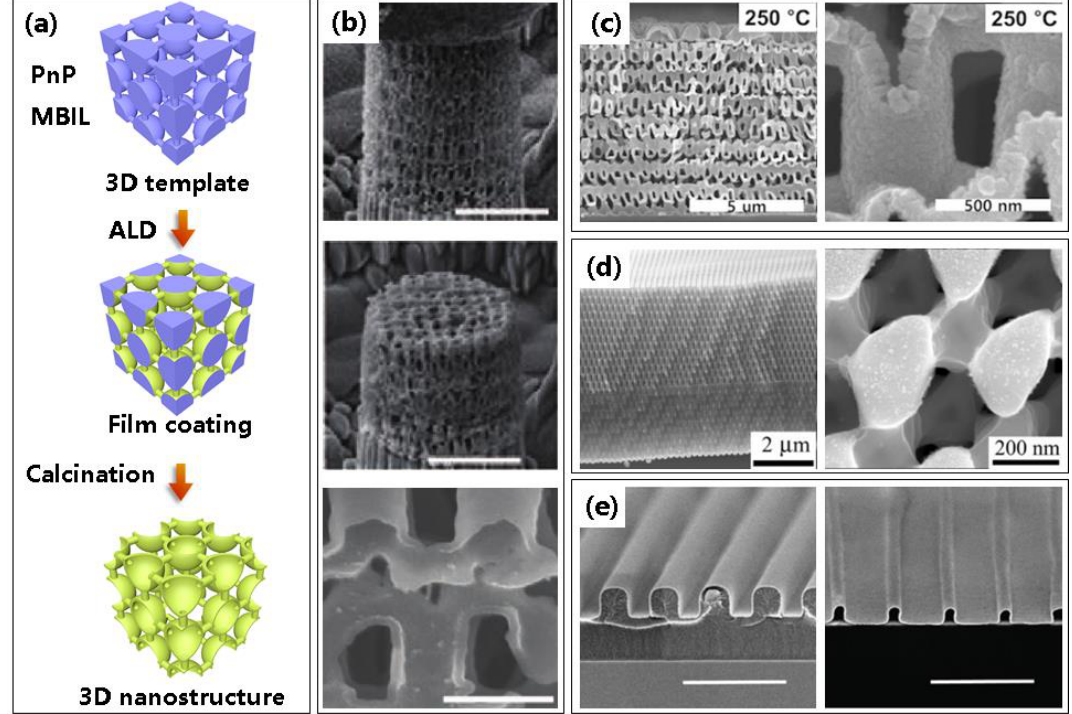
Figure 8. Other photoresist polymer templates by PnP and MBIL processes are used to fabricate 3D nanostructures by ALA methods. ( a ) Illustrated process routine of 3D nanostructures based on photoresist templates by PnP and MBIL techniques. The two techniques commonly share the same fabrication process, except the methods to fabricate resist templates. ( b ) SEM images of Al 2 O 3 nano- architectures based on PnP technique taken before and after compression tests. And the enlarged SEM images of Al 2 O 3 nano-architectures. Reprinted with permission from Ref. [72], Copyright 2018 WILEY-VCH Verlag GmbH & Co. KGaA, Weinheim. ( c ) SEM images of 3D ZnO hollow nanostructure deposited at 250 ◦ C after removal of the epoxy template based on PnP method. Reprinted with